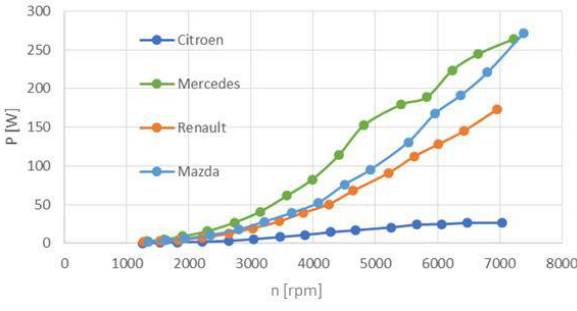
Fig. 11. Stream power of individual CPs as a function of rotor speed without